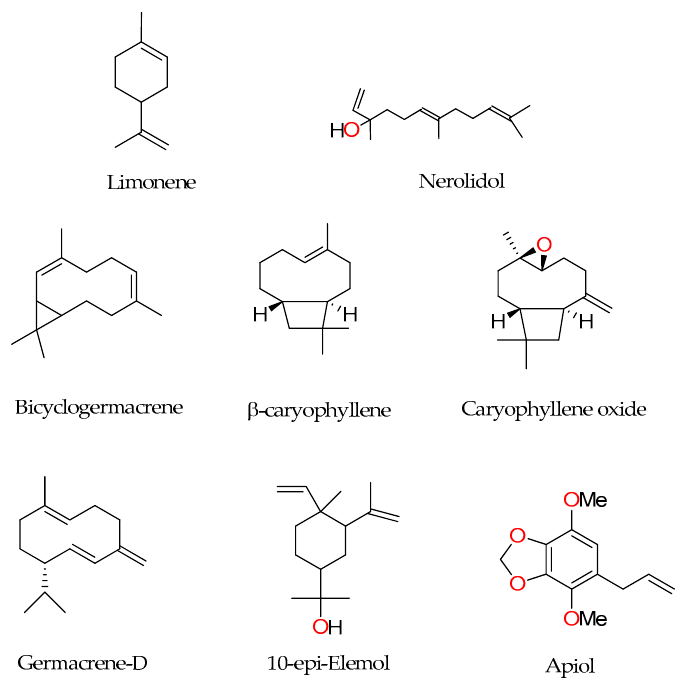
Figure 1. Main components of Piper essential oils.